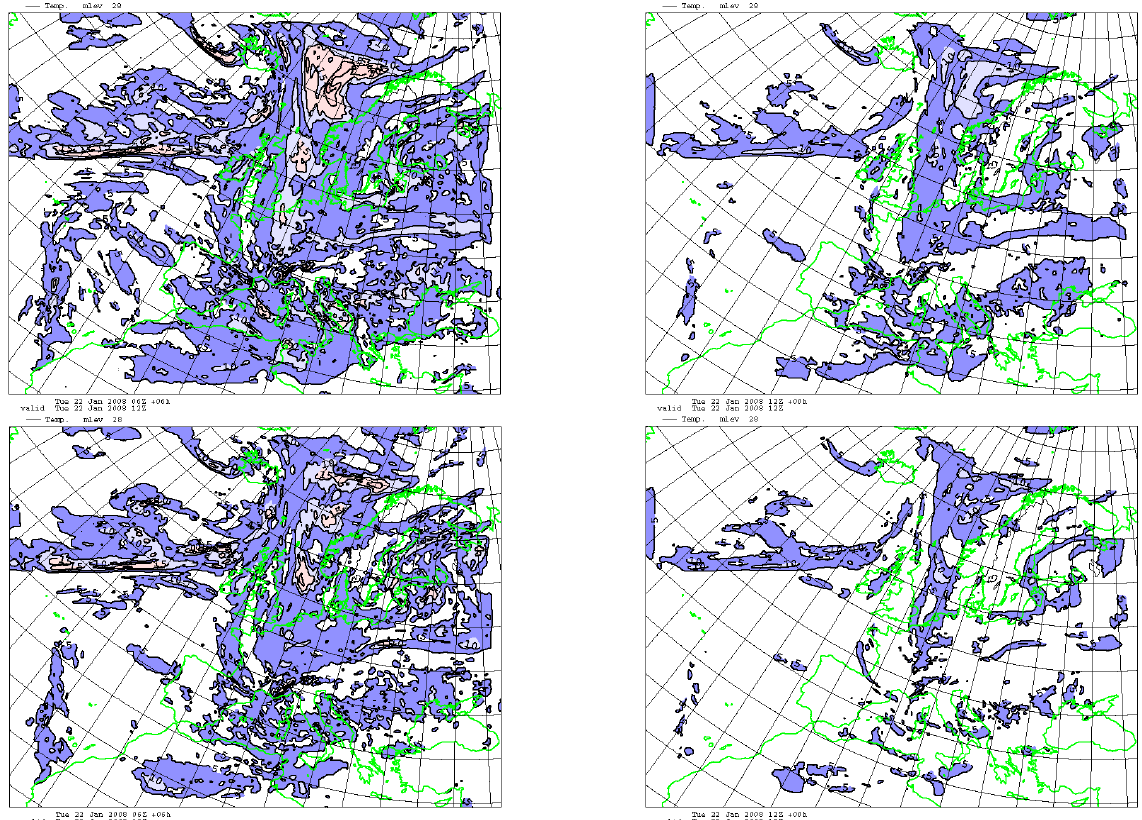
Fig. 9. Ensemble spread (RMS) for temperature at model level 28 ( ≈ 800hPa), 3D-Var hybrid (top panels) and 4D-Var hybrid (bottom panels), before ETKF re-scaling (left panel) and after ETKF re-scaling (right panels), 22 January 2008 12:00UTC. Isoline spacing 0.5K. The tuning factor κ has not been taken into